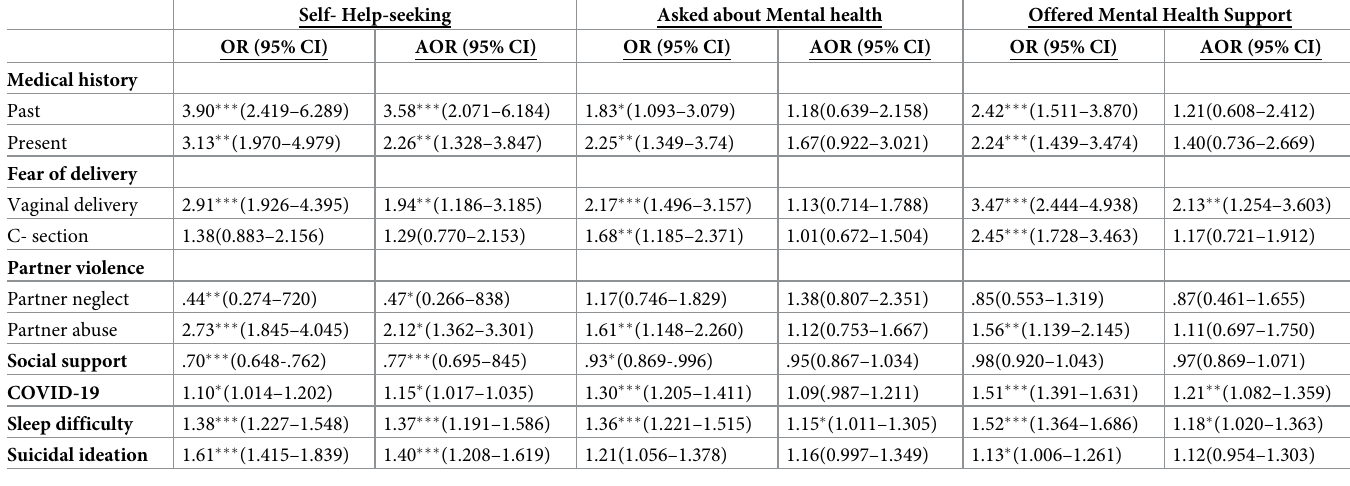
Demographic variables that evinced significant effect on the outcome variables (Table 2) were controlled for. Table 4. Predictors of mental health